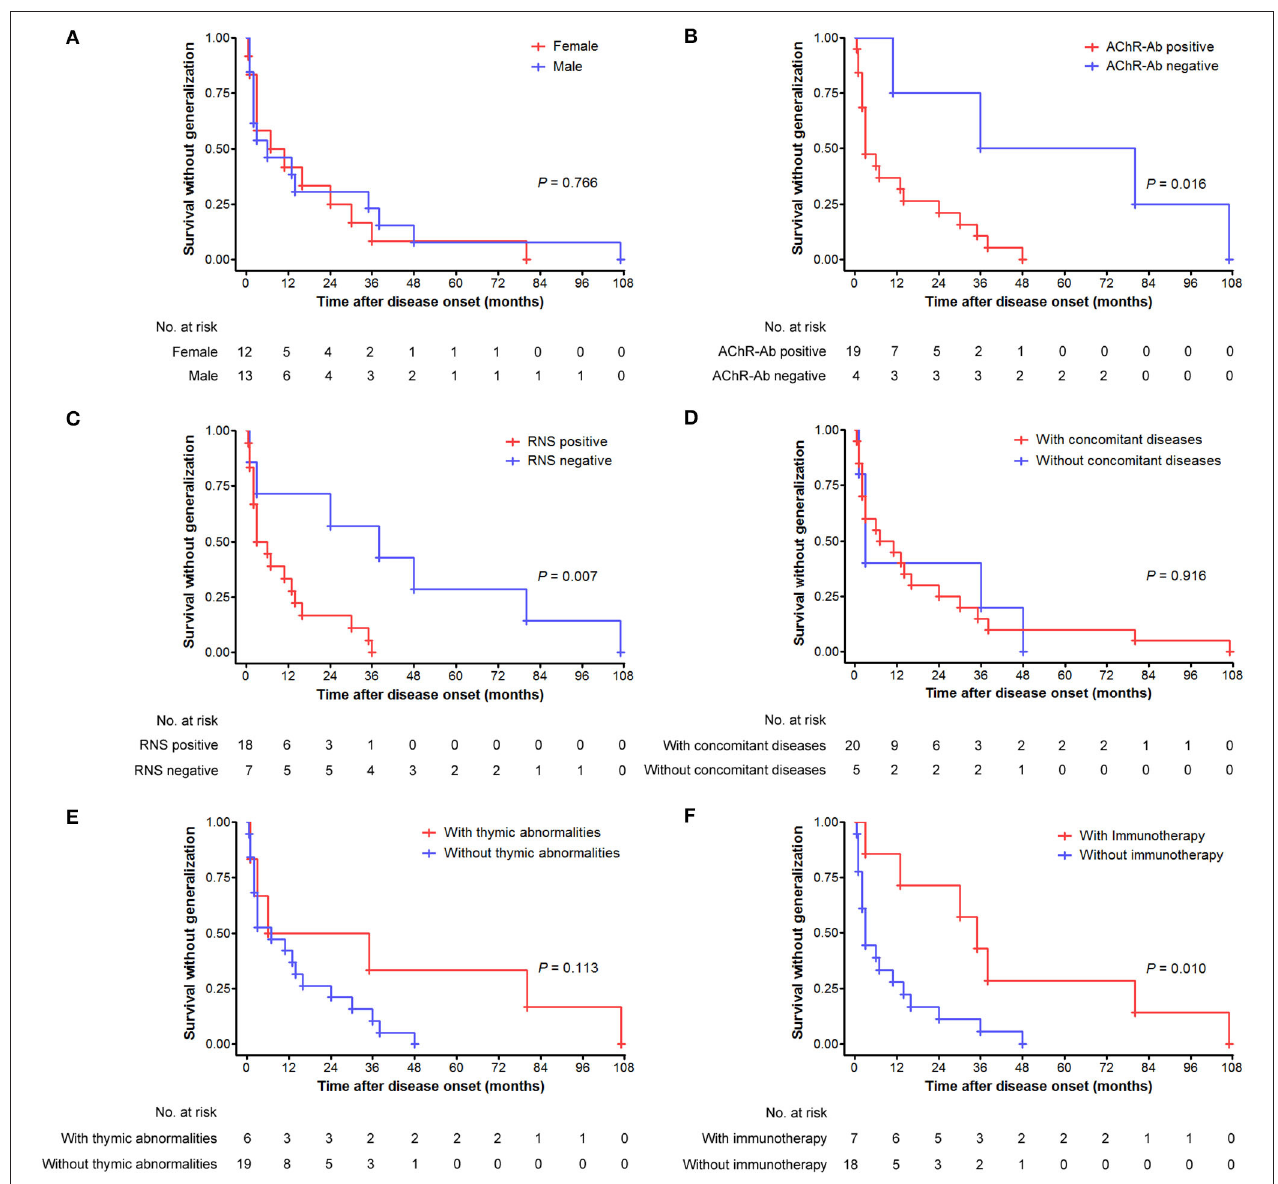
FIGURE 4 | Generalization tempo from disease onset over time (months) as depicted by the Kaplan–Meier curve. (A) Comparison between male and female patients. (B) Comparison between patients with positive and negative AChR antibody. (C) Comparison between patients with positive and negative RNS test results. (D) Comparison between patients with and without concomitant diseases. (E) Comparison between patients with and without thymic abnormalities. (F) Comparison between patients with and without immunotherapy before